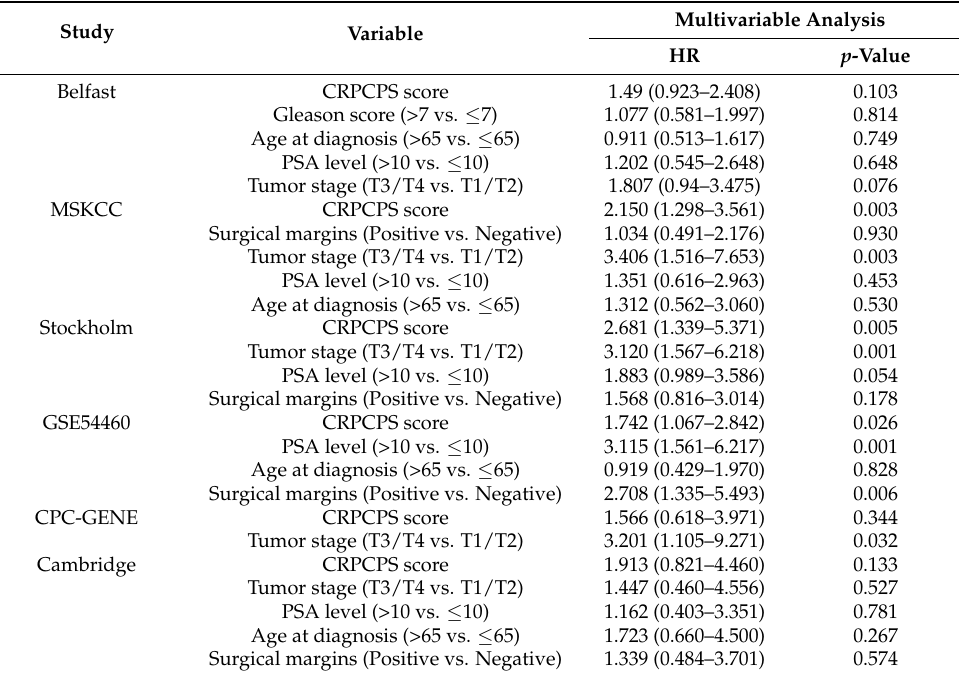
Figure 8. Univariate and multivariate Cox regression analyses of the CRPCPS score, patients’ age at diagnosis, Gleason score, tumor stage, and lymph node status in the TCGA training cohort ( a ), the internal validation cohort ( b ), and the entire TCGA cohort ( c ). The blue squares represent the hazard ratio (HR), and the black lines represent the 95% CI. CI, confidence interval. Age: age at diagnosis; Tumor stage: pathological tumor stage. Table 3. Multivariable analysis of the CRPCPS and clinicopathological characteristics in six additional independent